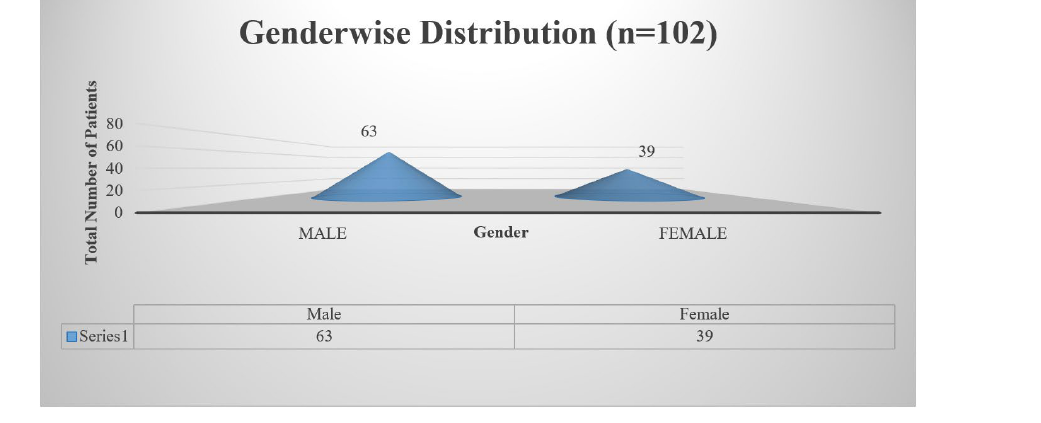
Fig. 1. Gender wise Distribution